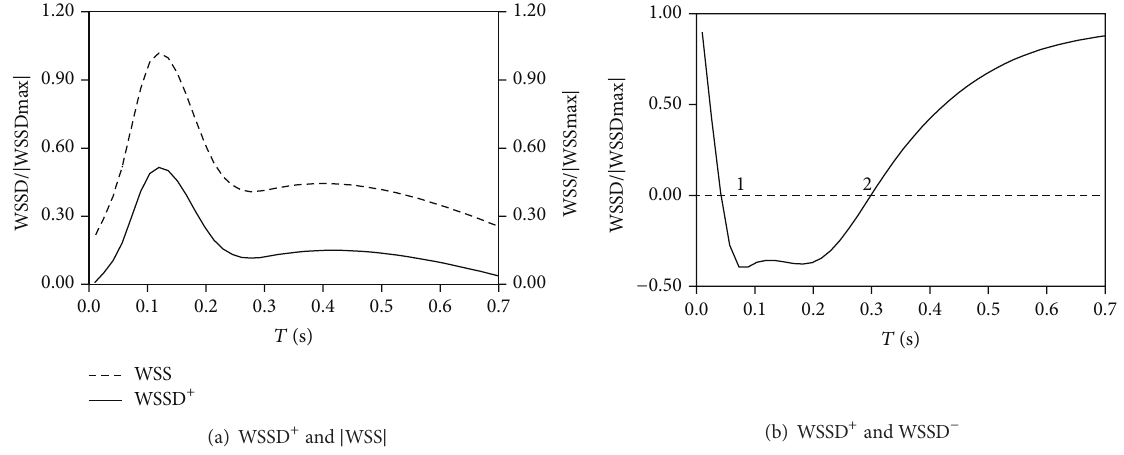
Figure 6: WSSD versus time for case